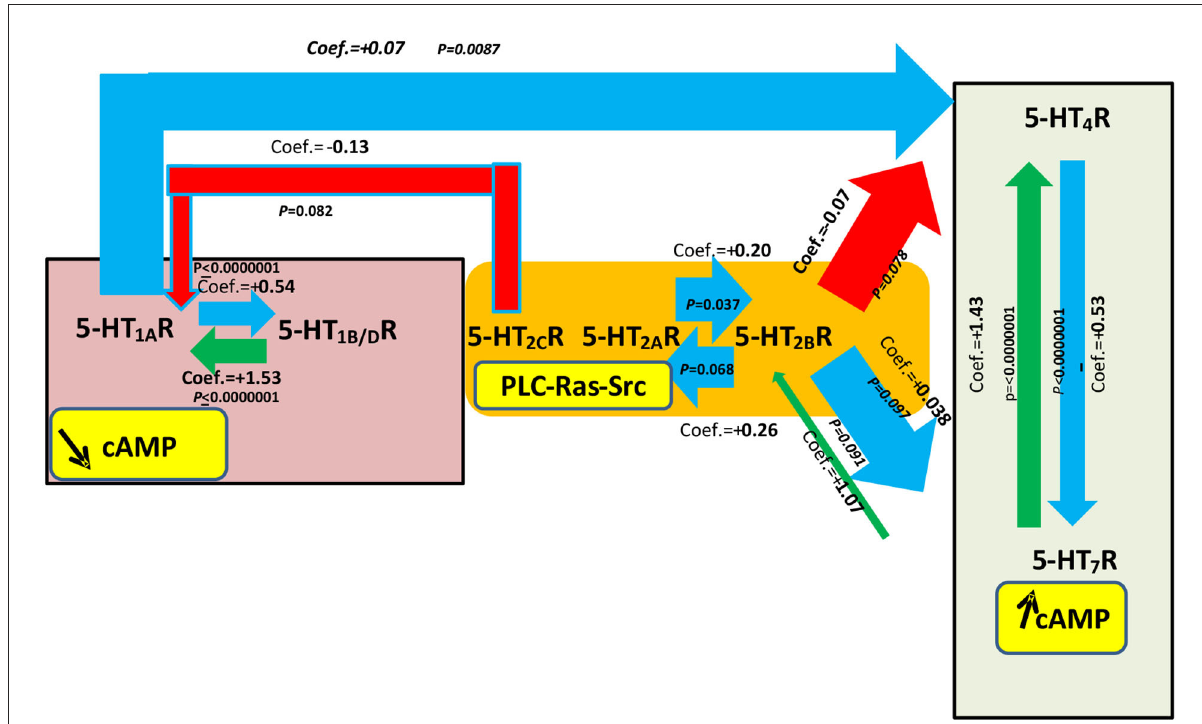
FIGURE3 Most significant statistical associations based on multivariate regression analyses for a specific 5-HTR level of expression with explicative variables being all other 5-HTR receptors and the implantation sites. This figure is based on Table 4. Seventy samples were included in each statistical analysis. See also the corresponding Supplementary Figure S2 adapted from Table 3 corresponding to the most significant statistical associations after multivariate regression analysis between 5-HTR levels with the explicative variables being another 5-HTR and the site of implantation. The yellow boxes show the main classical signal transduction pathways that are possibly activated after stimulation from specific 5-HTRs: 5-HT 1A R, 5-HT 1B / D R, 5-HT 2C R, 5-HT 2A R, 5-HT 2B R, 5-HT 4 R, and 5-HT 7 R especially with respect to the main signaling cAMP, but other signaling may also be present. The width of the arrows is proportional to the level of statistical correlation found following multivariate regression analysis. Only those comparisons between 5-HTRs with a P- value < 0.1 following multivariate regression analysis are shown in this figure. Blue arrows correspond to a correlation between 5-HTRs where the coefficient has an absolute value between 0 and 1 and is positive. Red arrows correspond to a correlation where the coefficient has an absolute value between 0 and 1 and is negative. In summary, as shown in this figure, statistically significant correlations were observed between levels for 5-HT 1A R and 5-HT 1B / D R and levels for 5-HT 4 R and 5-HT 7 R. For 5-HT4R levels, there was also a negative correlation with 5-HT1AR levels. Interestingly, we observed a negative correlation between 5-HT 2A R levels and 5-HT 2B R levels (coef. = + 0.20 [ − 0.02; 0.54]; P = 0.037). The yellow boxes show the main signaling pathways for each 5-HTR if their specific G protein is involved. These signaling pathways are just hypothetical in heart valves and need